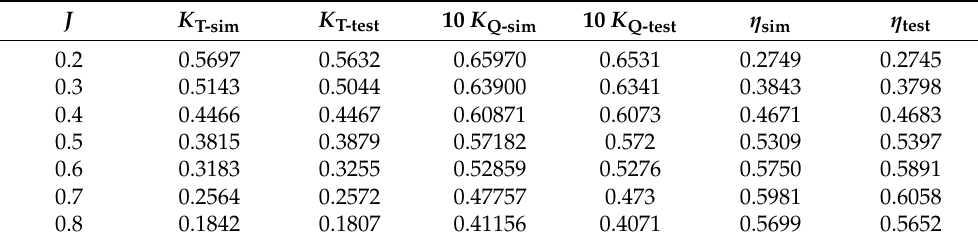
Table 5. Comparison between the simulation and test of the duct propeller